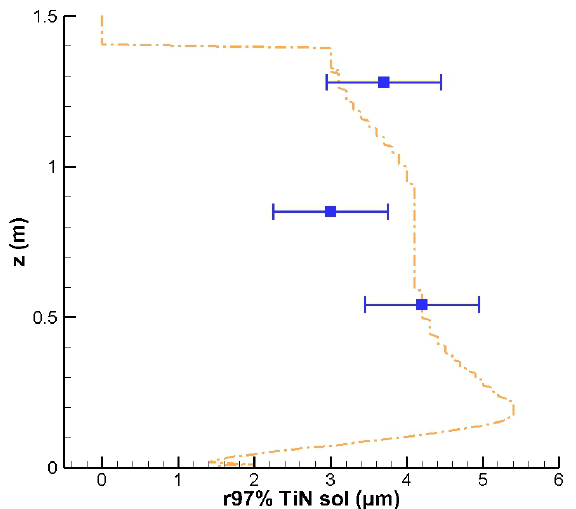
Figure 13. Comparison between the computed centerline r 97 (dotted line) with the